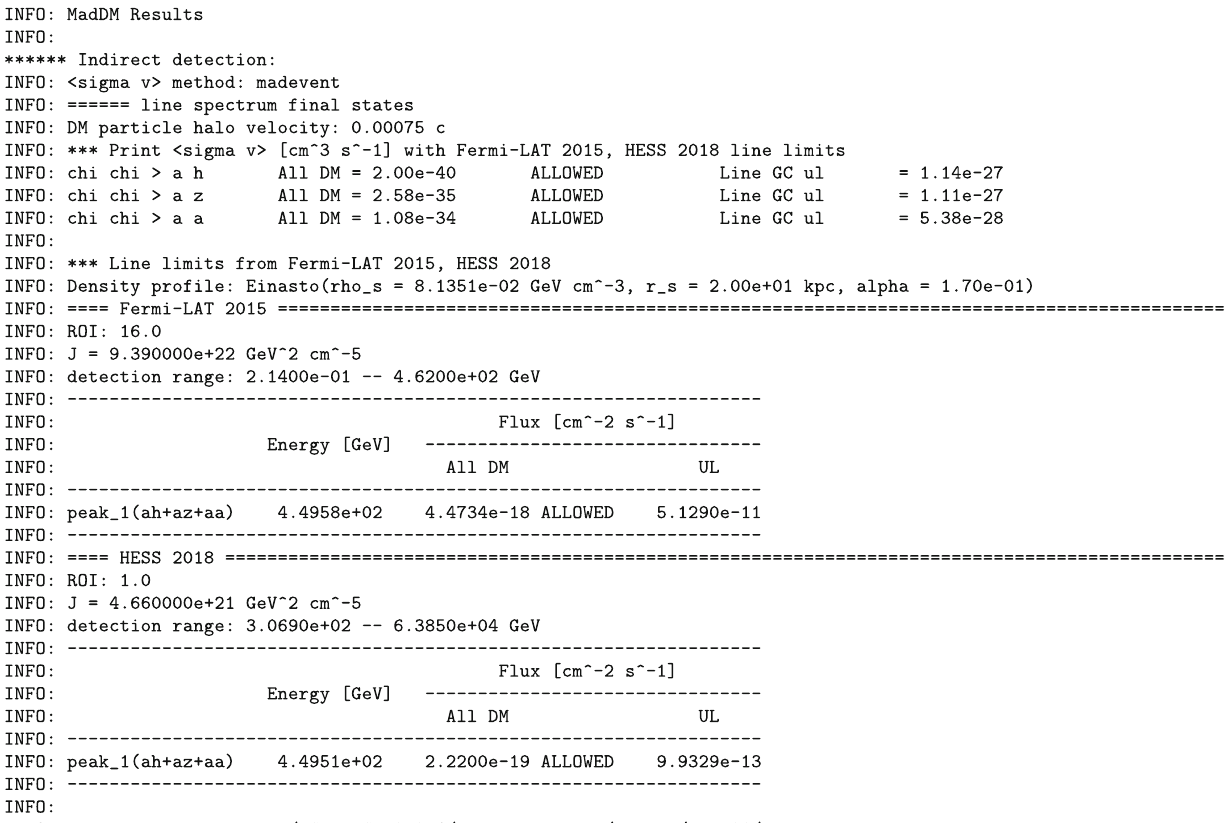
Fig. 5 Example of output provided by MadDM in gamma-ray line computations after the successful run of MadLoop . The numbers quoted correspond to the benchmark model point taken as an example in Appendix